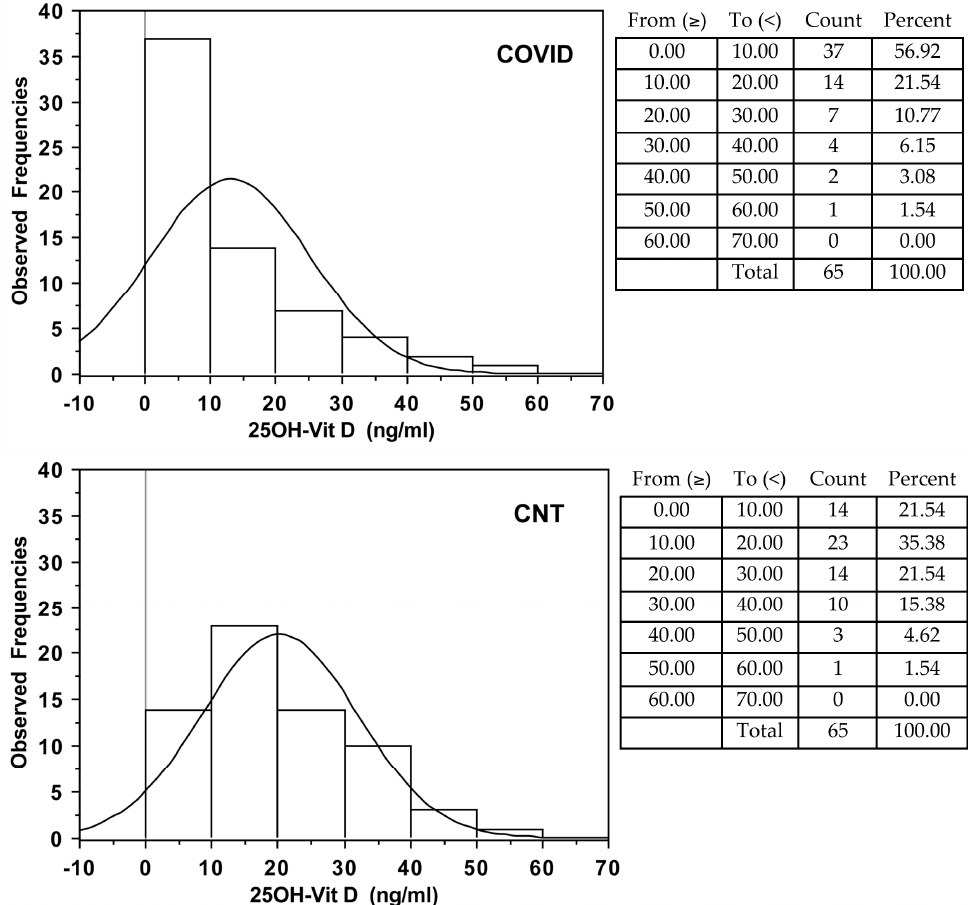
Figure 1. Observed frequencies of 25OH-vitamin D serum levels in COVID-19 patients and control subjects (CNT). Basal vitamin D serum levels were significantly lower in patients who died during hospitalization, compared to those who survived (median 3.0 vs. 8.4 ng/mL, p = 0.046) (Table 3). COVID-19 patients died in relation to the severity of the lung involvement and their comorbidities represented concomitant risk